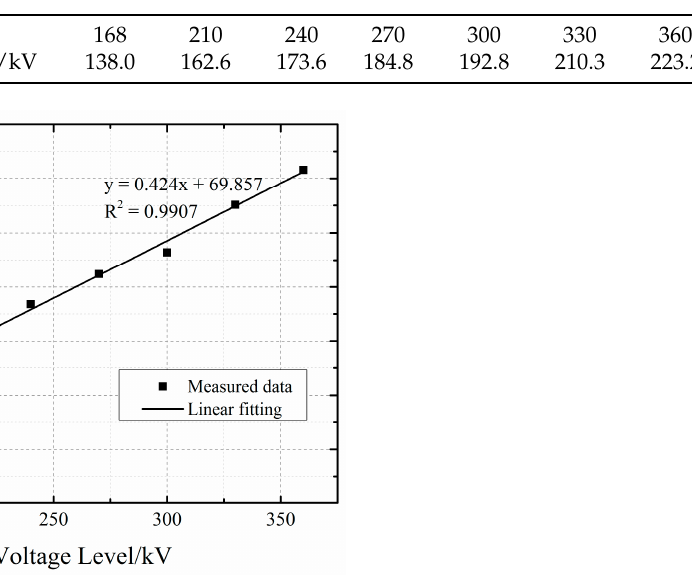
Table 2. The peak values of MOV overshoot voltage.